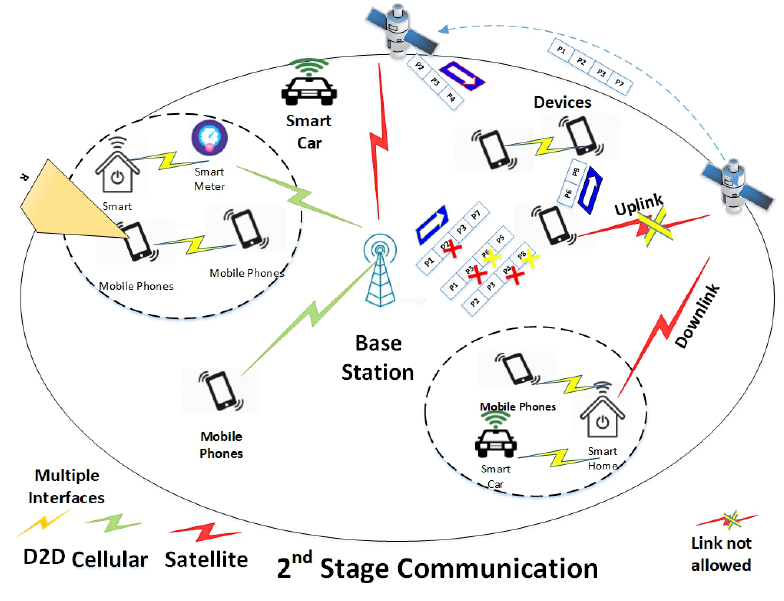
Figure 1. Network